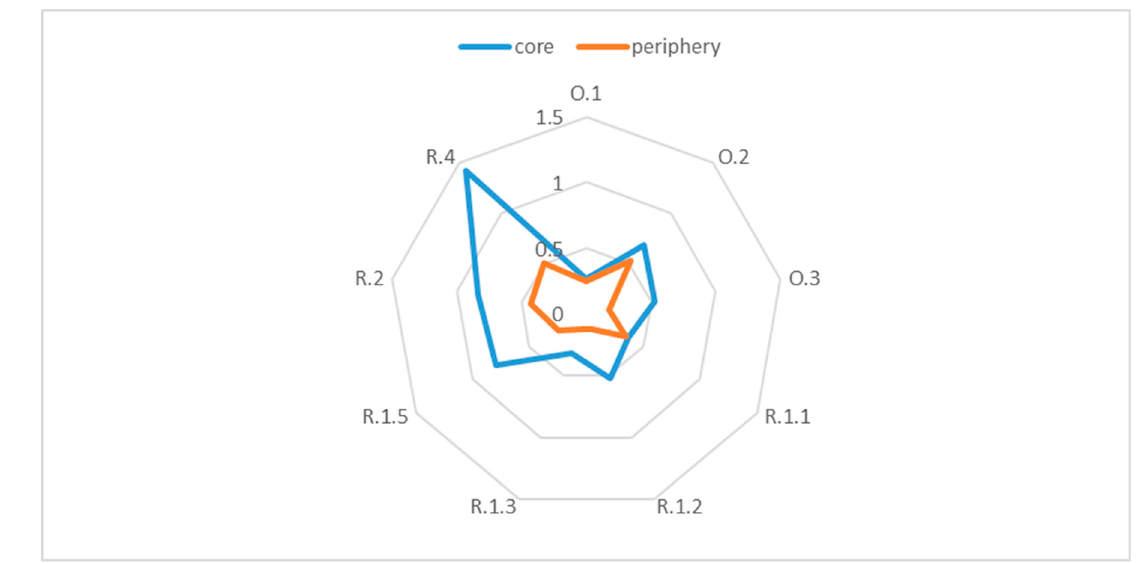
Figure 4. Land tenure attitudes at core and